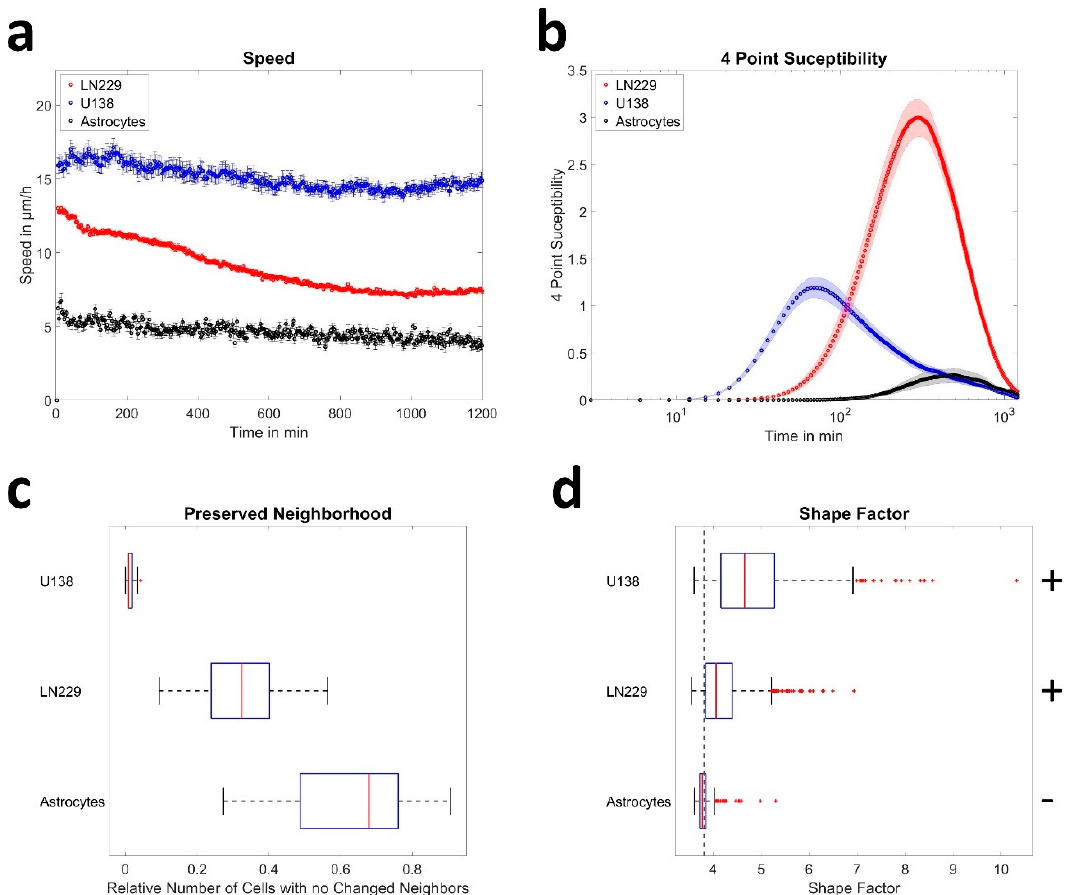
Figure 2. Collective migration properties of astrocytes and glioblastoma cells. ( a ) Graph of the mean speed per field of view over time, evaluated for 81, 33 or 18 fields of views for LN229, U138 or astrocytes, respectively. ( b ) 4-point susceptibility as obtained from the velocity fields over the whole measurement time. Peak positions of the 4-point susceptibility represent the average life time of collectively moving packs of cells. Sample sizes were identical as reported in ( a ). ( c ) Analysis of layer reorganization in terms of cells without making new neighbors. Sample sizes were identical as reported in ( a ). ( d ) Differences in shape factor between the cell types measured during live-cell imaging. The dotted line shows the critical value of 3.81 predicted by the vertex model. Below cells are considered to be jammed. “+” and “ − ” depict if shape factors are significantly larger or smaller than the critical value, with p < 0.0001 for all cell types, as tested with sign test. For shape factor calculation 2645, 772 or 269 LN229, U138 cells or astrocytes were measured from the fields of view. ( b , c ) Error bars and shaded areas depict the standard error of the mean. ( c , d ) Box plots show the median (red line), 25 and 75 percentile (box), non-outlier range (whiskers) and outliers (red dots).